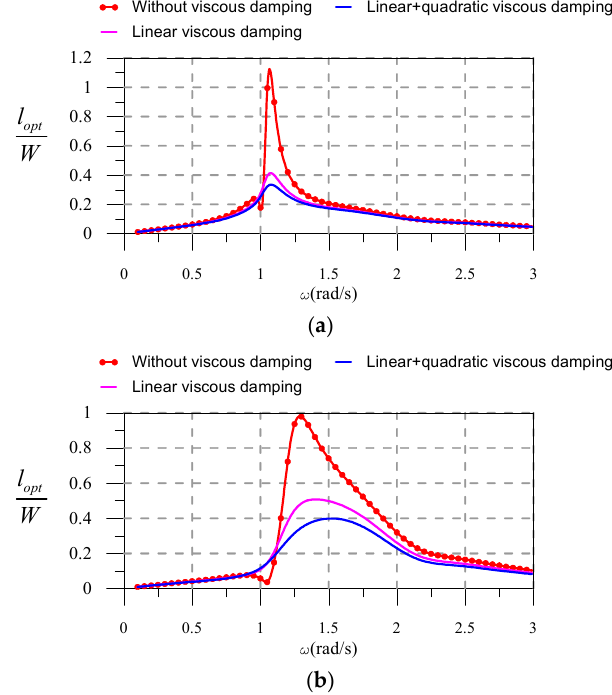
the wave frequency.